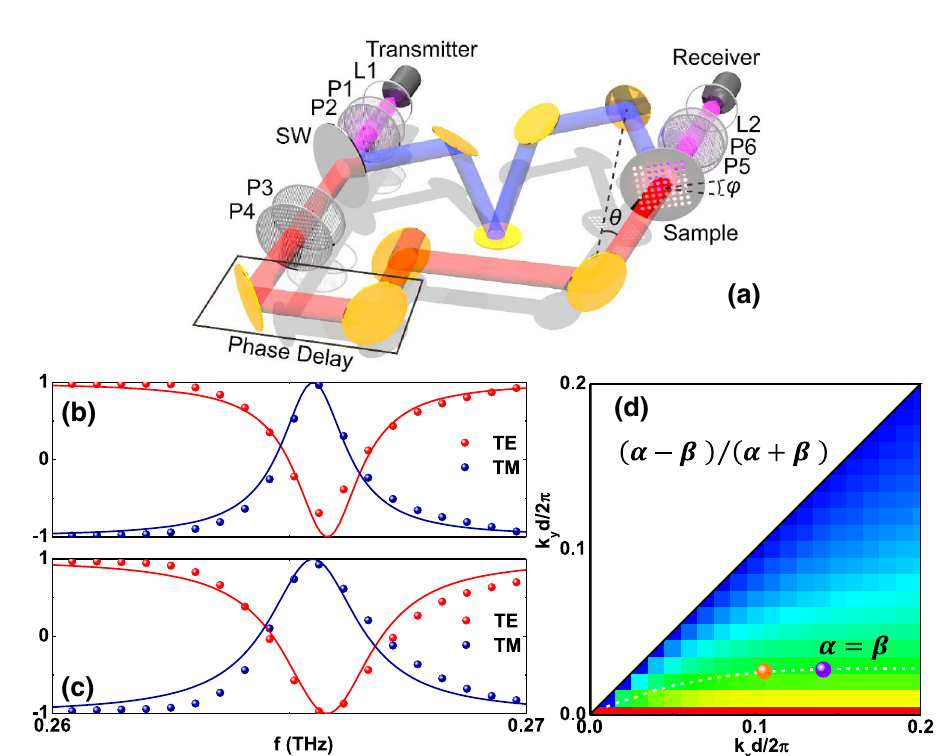
Fig. 5 Coherent perfect polarization conversion. Experimental setup ( a ) and perfect polarization conversion under symmetric incidence at incident angles ð θ ¼ 15 o ; φ ¼ 14 o Þ ( b ) and ð θ ¼ 20 o ; φ ¼ 11 o Þ ( c ). The perfect polarization conversion point lies on the critical coupling curve in the contour plot ( d ), ¼ 0 : 2658 THz, f TM ¼ 0 : 2655 THz, and α 2 ¼ 0 : 02027 2 THz for ð θ ¼ 15 o ; φ ¼ 14 o Þ . Fitted parameters consistent with Fig. 2c. Fitted parameters are f TE 0 0